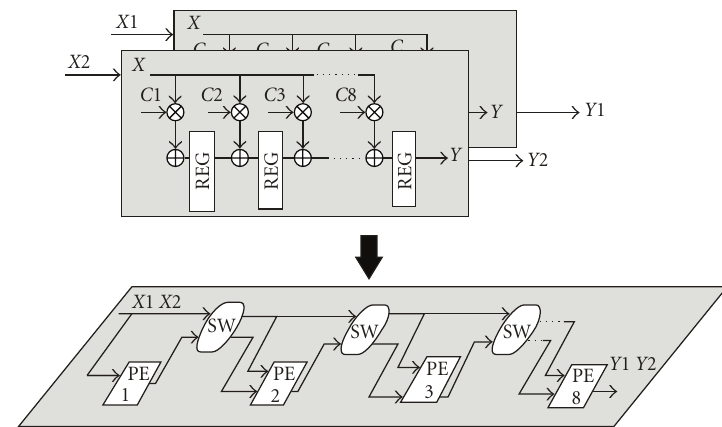
Figure 20: Configuration of 2-channel, 8-tap Polyphase filters on an RSA consisting of a 1-by-8 array of PE